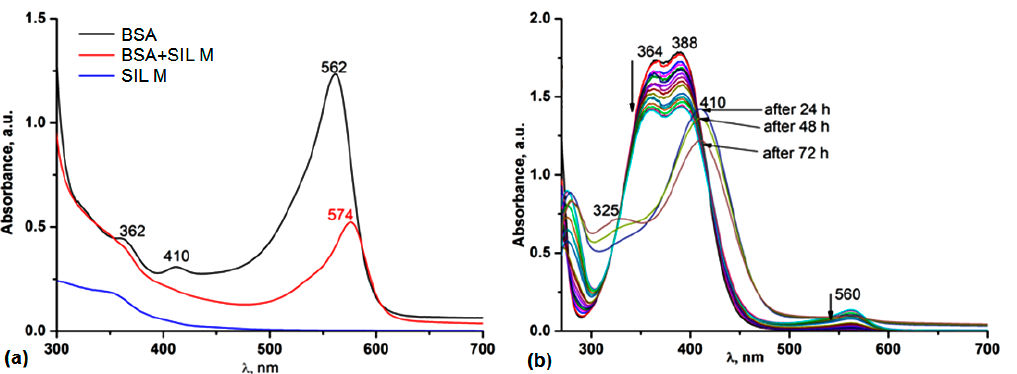
Figure 4. UV-vis spectra of SIL M ( a ) and SIL-BS ( b ) during and after titration with protein (BSA) solution 10%.